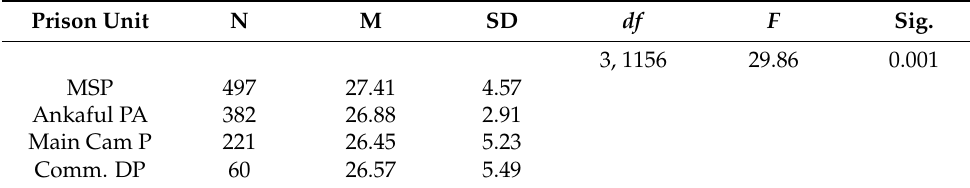
Table 2. Differences in inmate stress levels by their units of prison. Prison Unit